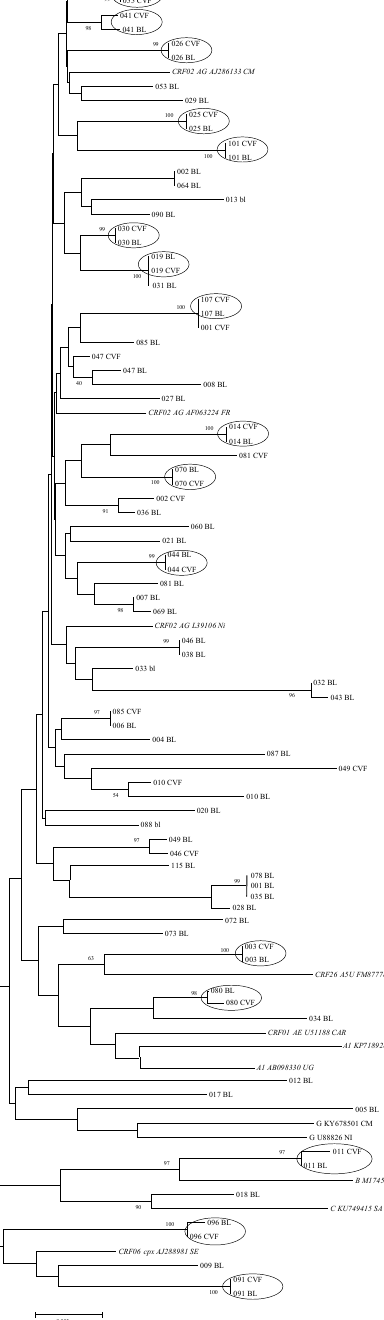
Figure 1. Phylogenetic tree based on reverse-transcriptase and protease genes of 84 samples obtained from blood (BL, n = 60) and cervicovaginal fluid (CVF, n = 24). Strains from the same patient exhibiting identical sequences are shown in a circle (bootstrap values above 96%).